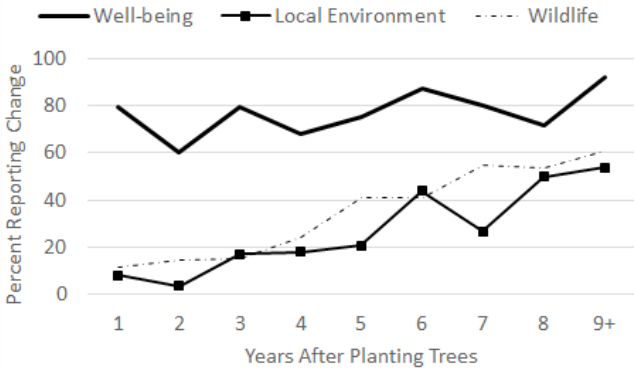
Figure 2: Changes in Property Reported by Participants by Tree